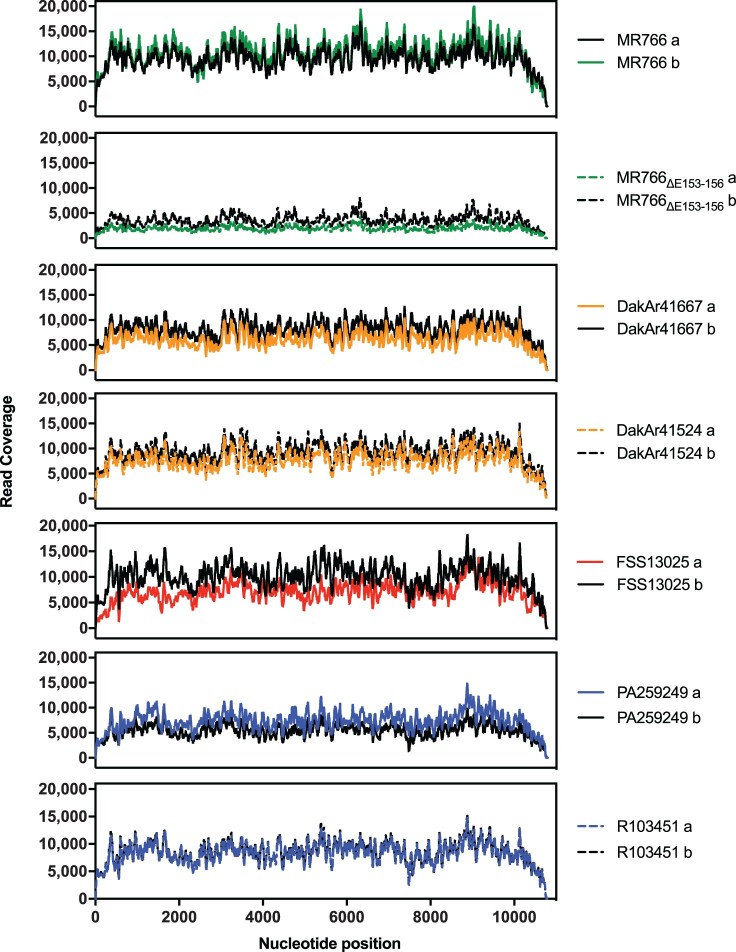
ZIKV NGS sequencing dataset description. Duplicate samples (N = 14) of each strain were analysed. The positional read coverage depth of each replicate (after filtering out low-quality reads and PCR replicates) was plotted along the genome and was similar for both replicates of each strain. Coverage range: 1,906-10,762.